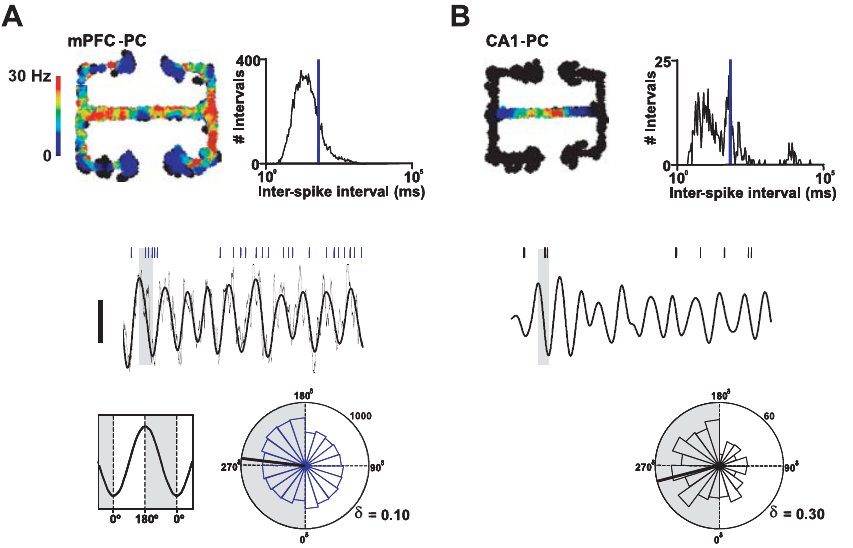
Figure 5. Spike-Timing in CA1 and mPFC Populations Was Phase-Locked to CA1 Theta Rhythm Firing-rate maps for representative mPFC (A) and CA1 (B) pyramidal cells. Graphs show inter-spike interval distributions (blue line marks 10 Hz). Thick black lines show CA1 LFP band pass filtered at 4–12 Hz during single central-arm crossings (scale bar 0.5 mV, length 1.3 s and 1.4 s in A and B, respectively) with spike times of the two neurons above marked by ticks. Raw LFP is shown by the thin black line in A. Rose histograms show phase distributions for these single mPFC (blue) and CA1 (black) neurons with respect to CA1 theta rhythm. Thick black lines mark mean preferred phase. The numbers on the outer circular axis give spike counts. Circular-concentration coefficients are given by j . Both distributions are significantly nonuniform ( p , 0.01, Rayleigh test). DOI: